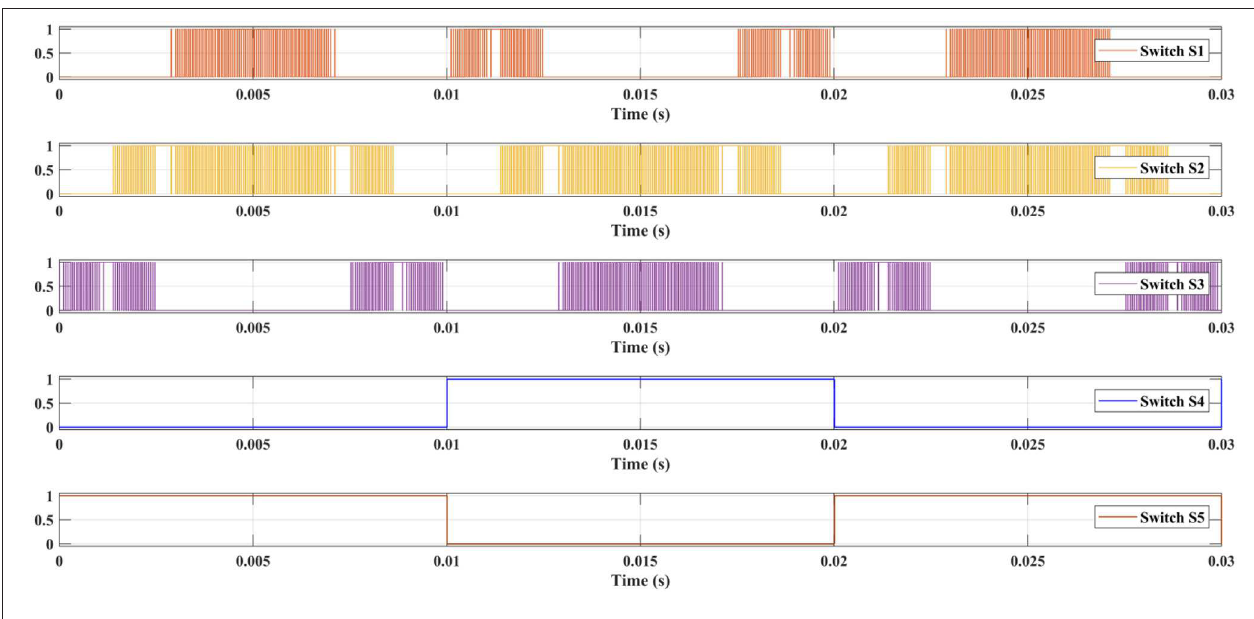
FIGURE 7 | Pulse sequence of RSMLI.